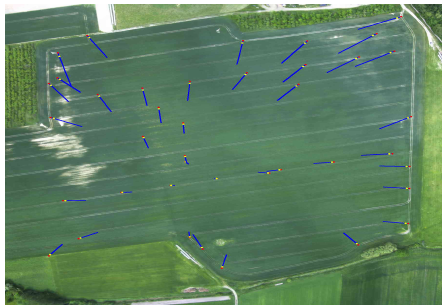
Figure 11: Orthophoto accuracy measurement with ground control points (red), corresponding RTK-GNSS measurements (yellow) and deviation vectors scaled by a factor of 10 (blue). The captured area is about 550 m × 550